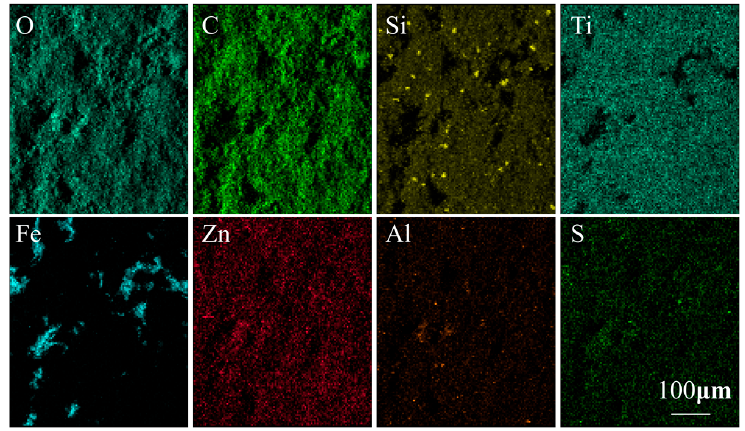
Figure 9. Element distribution of nano-ceramic coating specimen after vulcanization.